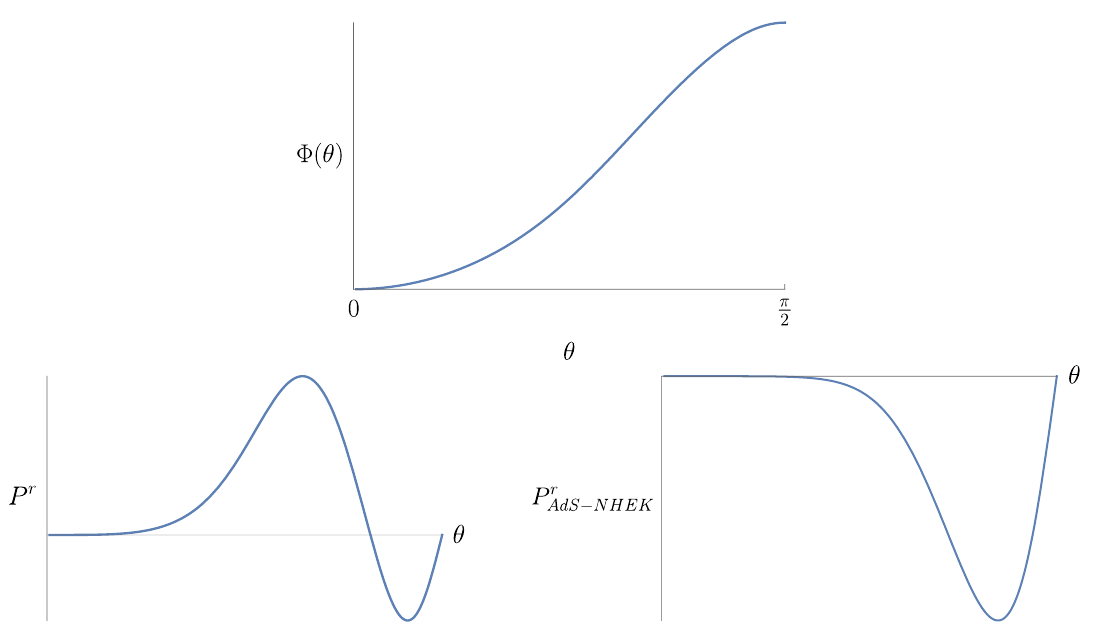
Figure 3 . Solution Φ( θ ) and corresponding Poynting flux P r as a function of θ , for the AdS- NHEK scaling solution for parameter values h = 1 , I 0 = 0 . 2 , ‘ = 1 , a = − 0 . 25 , k = − 0 . 68 , ω 0 = 1 r + = 0 . 226654 and Ω ext = − 2 . 06 , and with Φ( π/ 2) = 1 . 585633 . The near horizon flux P r H is inwards while P r does detect energy